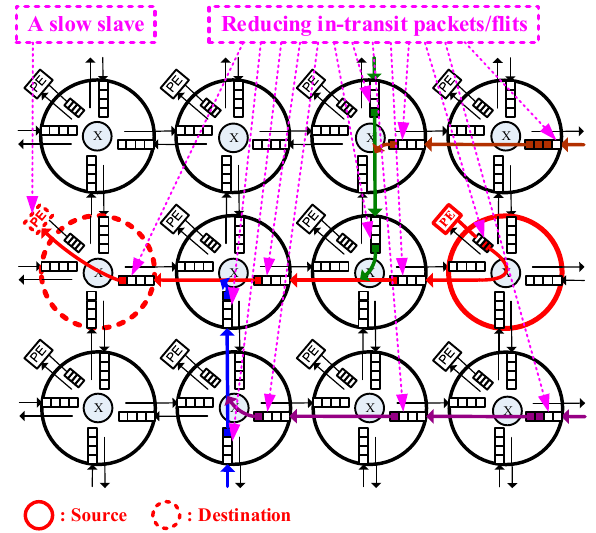
Figure 2. Congestion tree with less in-transit packets/flits.